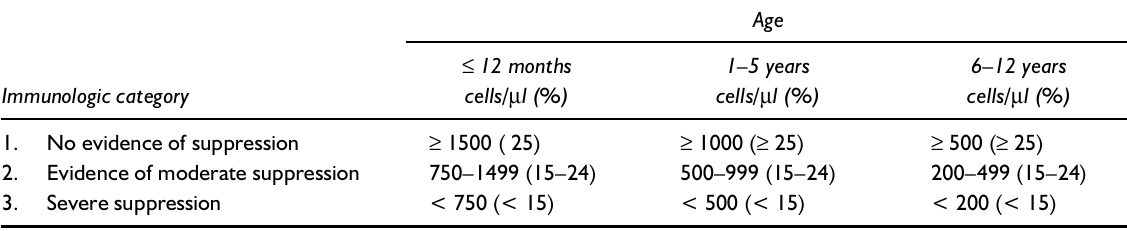
Table 10 Immunologic categories for human immunodeficiency virus-infected children based on age-specific CD4 + T lymphocyte counts and percentage of total